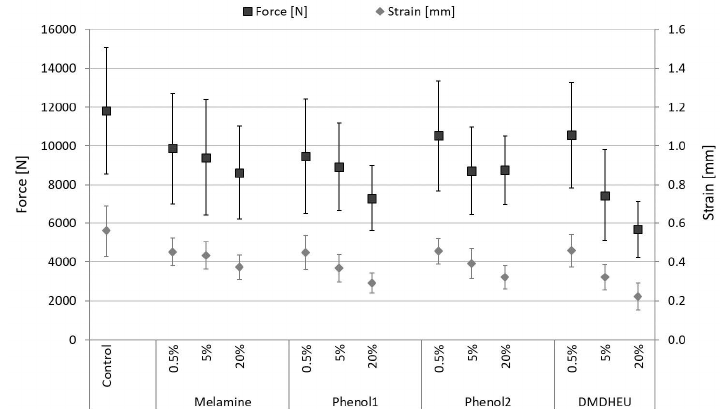
Figure 5. Maximum force (N) and strain (mm) in traction depending on modification agent and concentration (mean and SD).